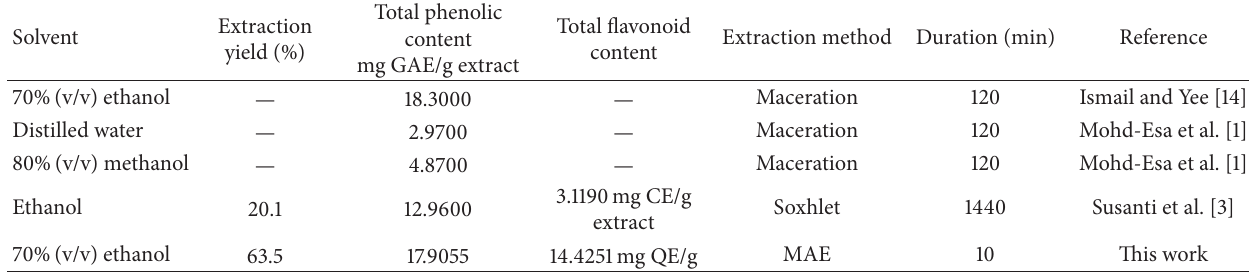
Table 3: Comparison of microwave assisted extraction (MAE) and conventional extractions from previous studies.